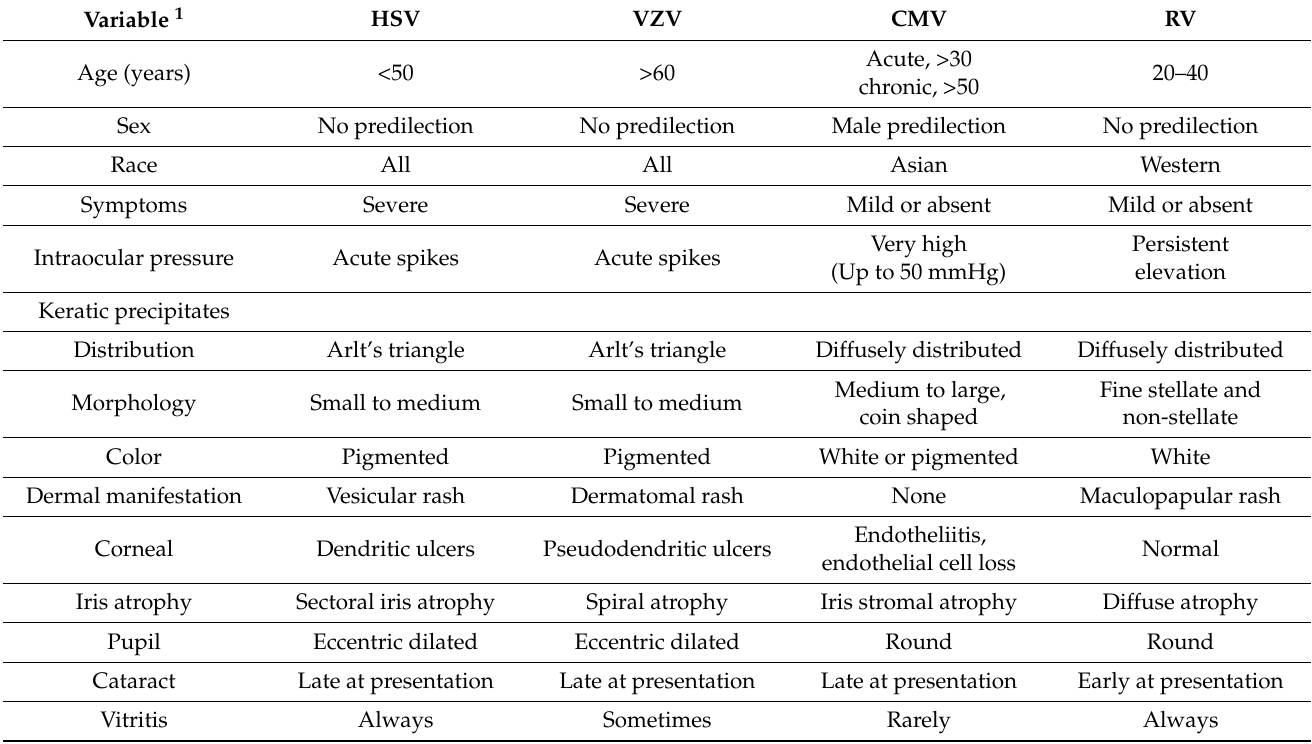
Table 1. Comparison of clinical features between common viral anterior uveitis